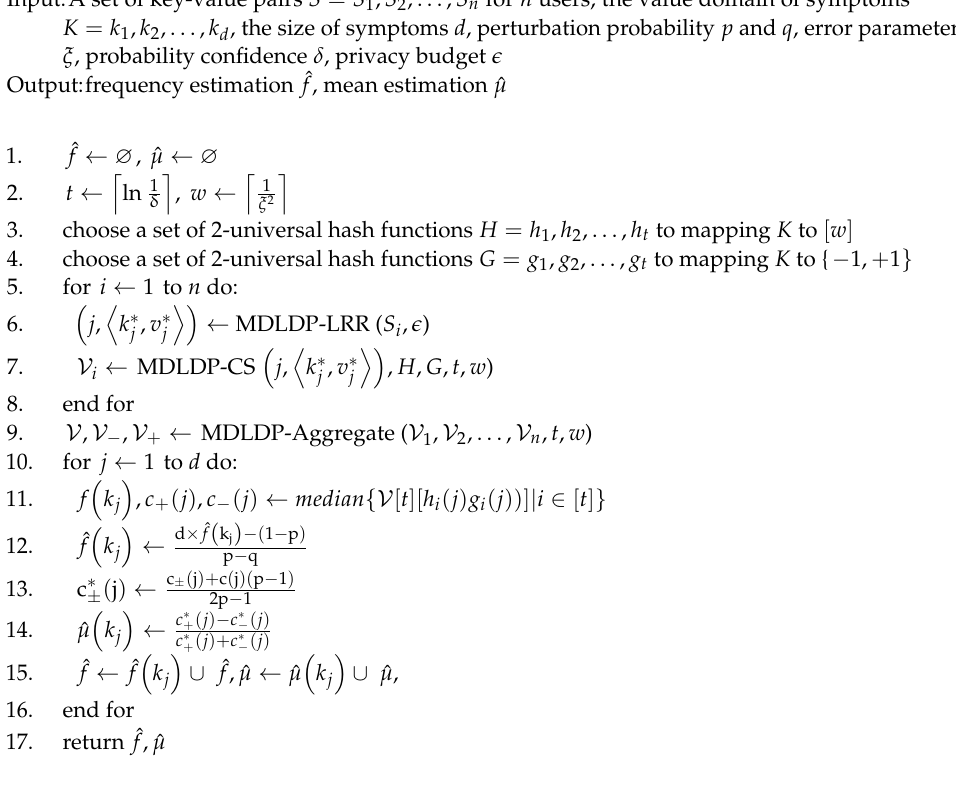
Algorithm 1: MDLDP Algorithm 1: MDLDP algorithm